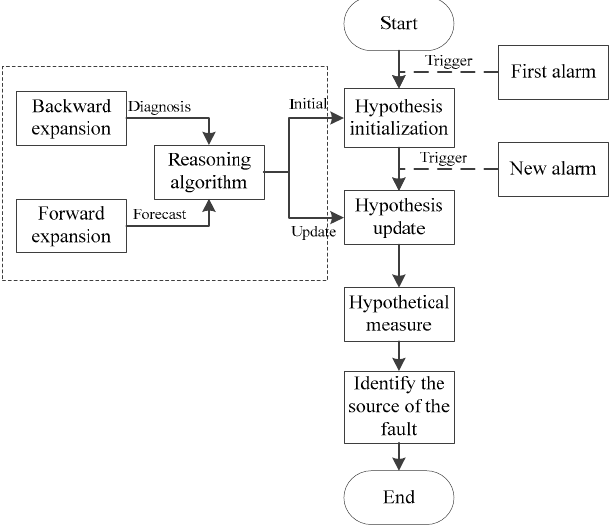
Figure 5. Fault diagnosis process based on TFPG.